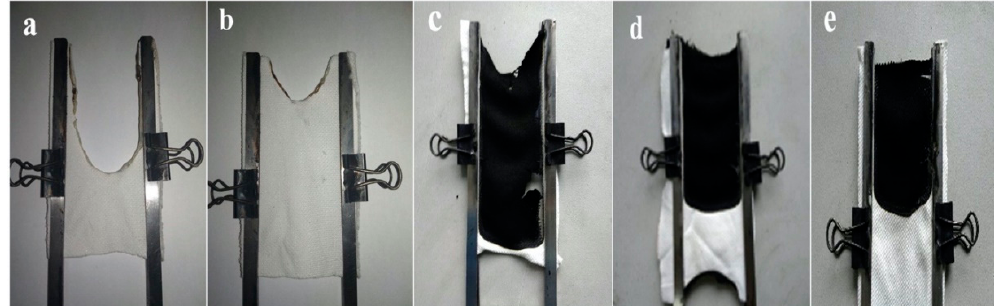
Figure 20. Digital images of uncoated and coated polyester fabrics after Limiting Oxygen Index testing. ( a ) uncoated polyester, ( b ) LbL-treated polyester—1 bi-layer, ( c ) LbL-treated polyester—5 bi- layers, ( d ) LbL-treated polyester—10 bi-layers and ( e ) LbL-treated polyester—20 bi-layers. Reprinted with permission from [50]. Copyright 2019, Elsevier.